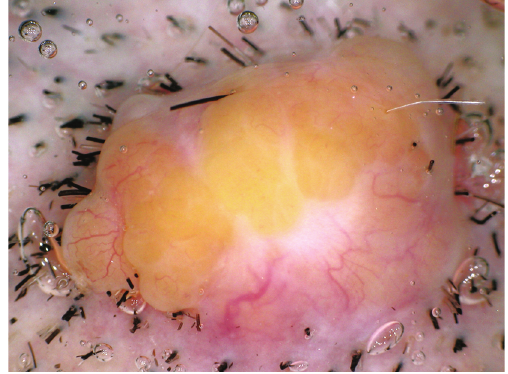
Figure 4: The tumor is composed of basaloid cells with deeply basophilic oval nuclei showing a typical rippled